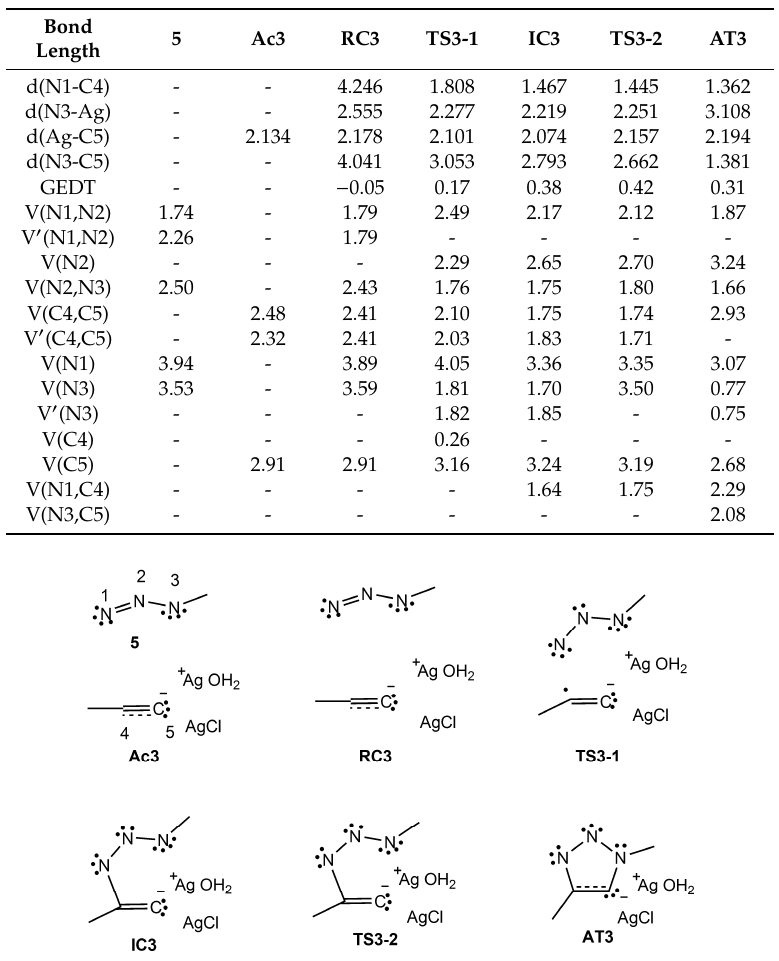
2.91 e. These valence basins, which can be associated with an overpopulated C4-C5 double bond and an overpopulated C5 carbanionic center, reveal the ionic nature of Ac3 (see Table 3). Table 3. ELF valence basin populations, values of the distances of the forming bonds and global electron density transfer (GEDT) of the stationary points involved in the dinuclear zw -type AgAAC reaction of Ac3 with 5 [the values of the distances are given in Å and those of the GEDT and electron populations in average number of electrons (e)].